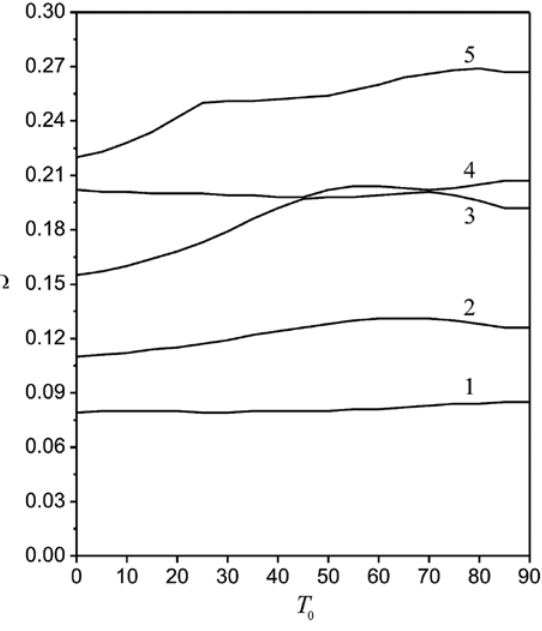
= 30 ° ) for the first five ( T 0 1 / T 〉] circular laminate. 0 1 s